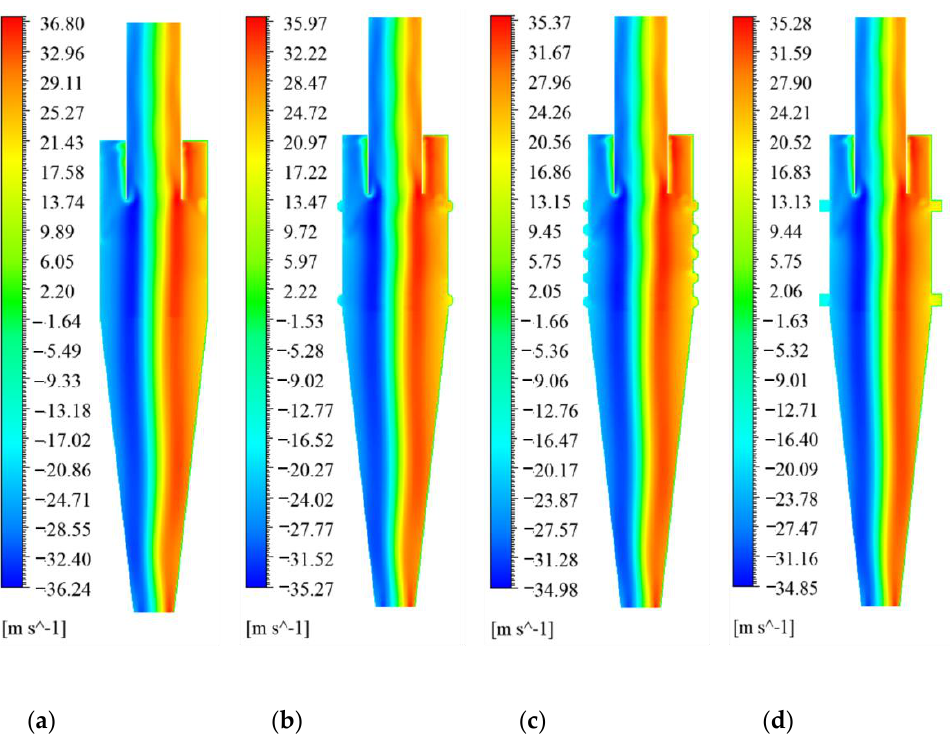
Figure 8. Contour plots of tangential velocity of cyclone models; ( a ) Model A (Stairmand cyclone separator), ( b ) Model B cyclone separator, ( c ) Model C cyclone separator, ( d ) Model D cyclone separator.